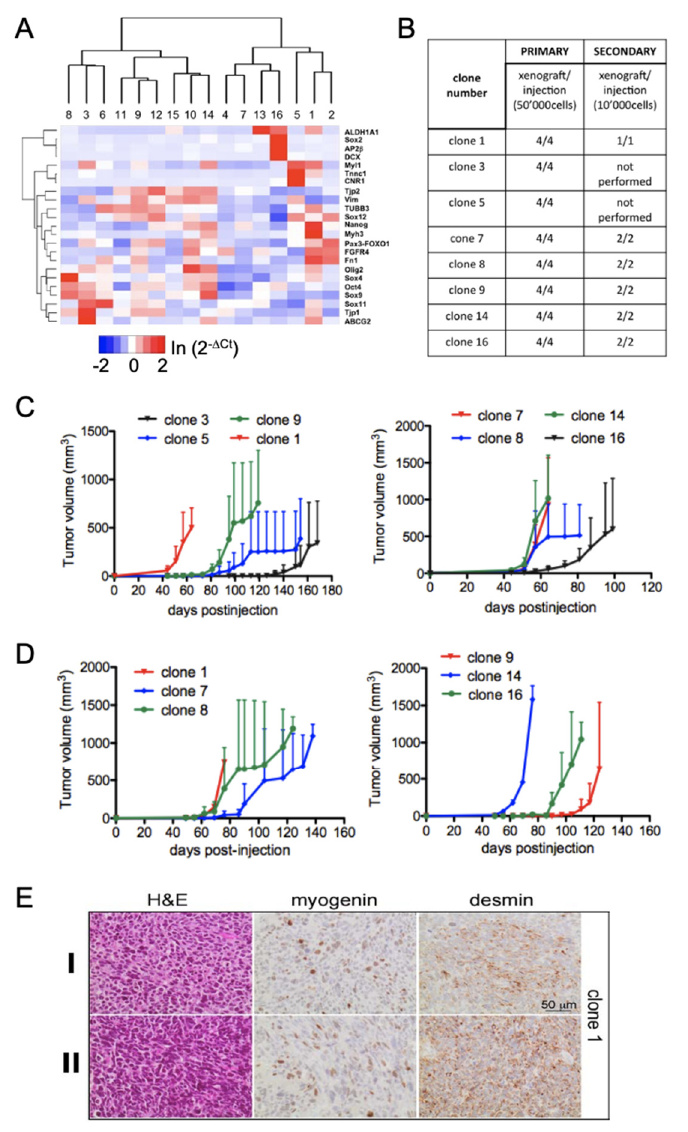
Figure 6. Clonal analysis of cells. ( A ) Heat map of qRT-PCR of total RNA relative to GAPDH from RH30 single-cell derived clones. Sixteen clones were analyzed for the expression of the genes indicated. Scale bar ln(2 − ∆ Ct ). ( B ) Generation of primary and secondary xenografts with 8 selected RH30 clones. For primary xenograft generation 5 × 10 4 cells were injected i.m into the left leg of NOD/Scid mice ( n = 4). Single cell suspensions (10 4 cells) of primary tumors were injected i.m into mice ( n = 2) for secondary tumor formation. ( C ) Tumor growth of primary xenograft clones generated from one RH30 cell. ( D ) Tumor growth of secondary xenografts. ( E ) Immunohistochemical staining of primary (I) and secondary (II) xenograft sections of clone 1. Tumors were stained with hematoxylin and eosin (H&E) and the FPRMS markers MYOGENIN and